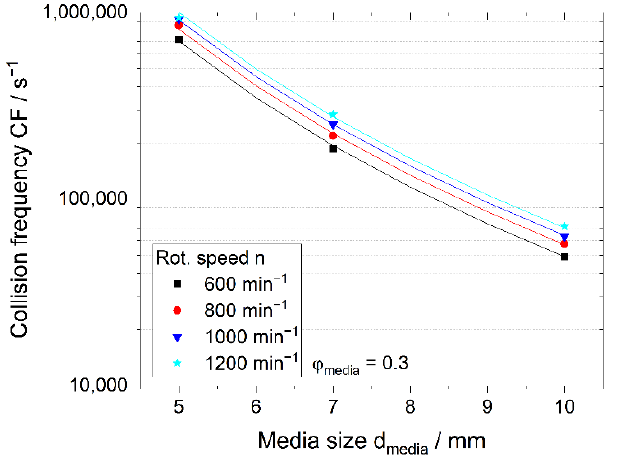
Figure 6. Collision frequency as a function of media size for varied rotation speeds, ϕ media = 0.3 (fit functions are based on Equation (16)).